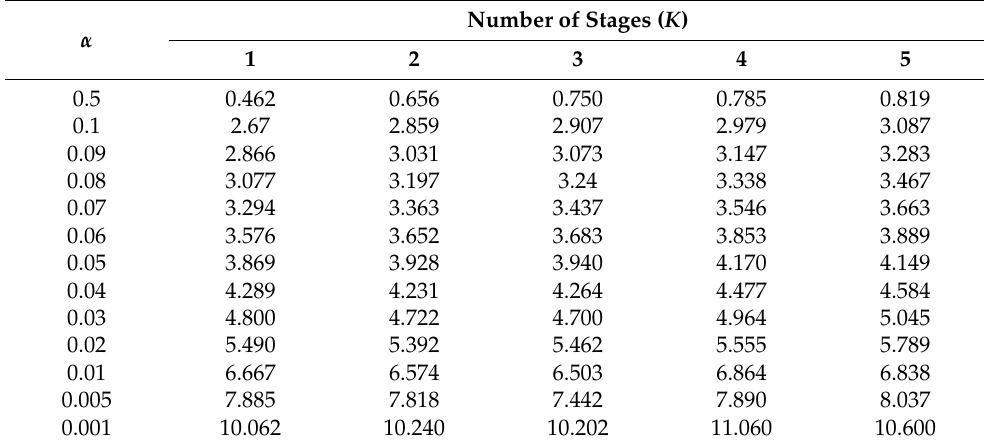
Table 1. The O’Brien and Fleming original critical